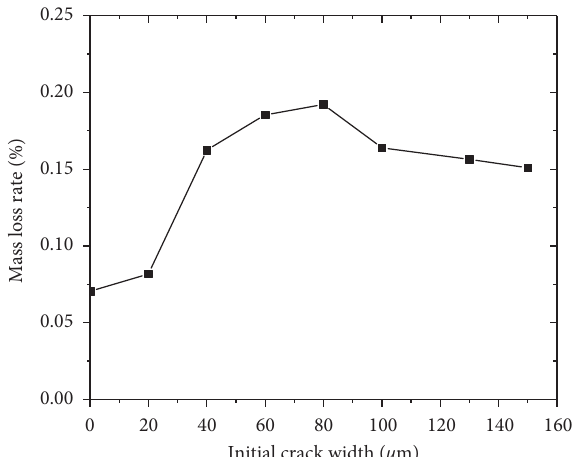
Figure 6: The mass loss rate of the specimens after 28 salt-freezing cycles.